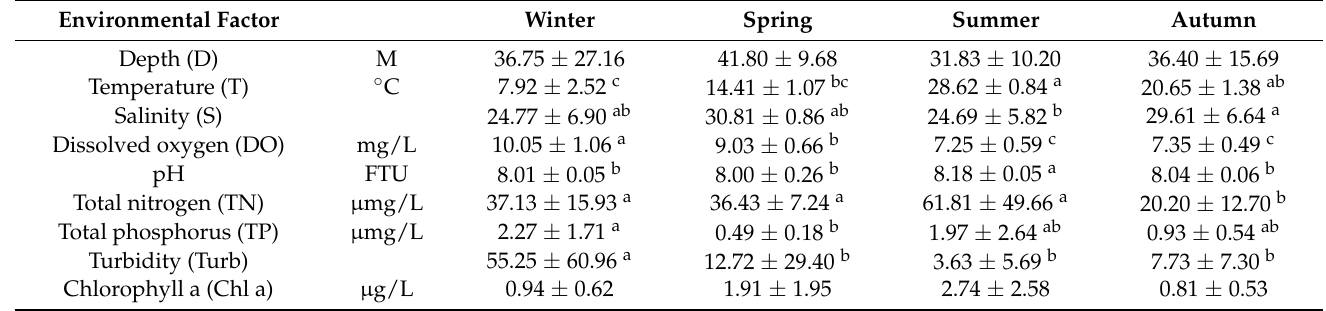
Table 1. Seasonal variation in environmental factors, Yangtze Estuary and adjacent waters, 2018 (Mean ±